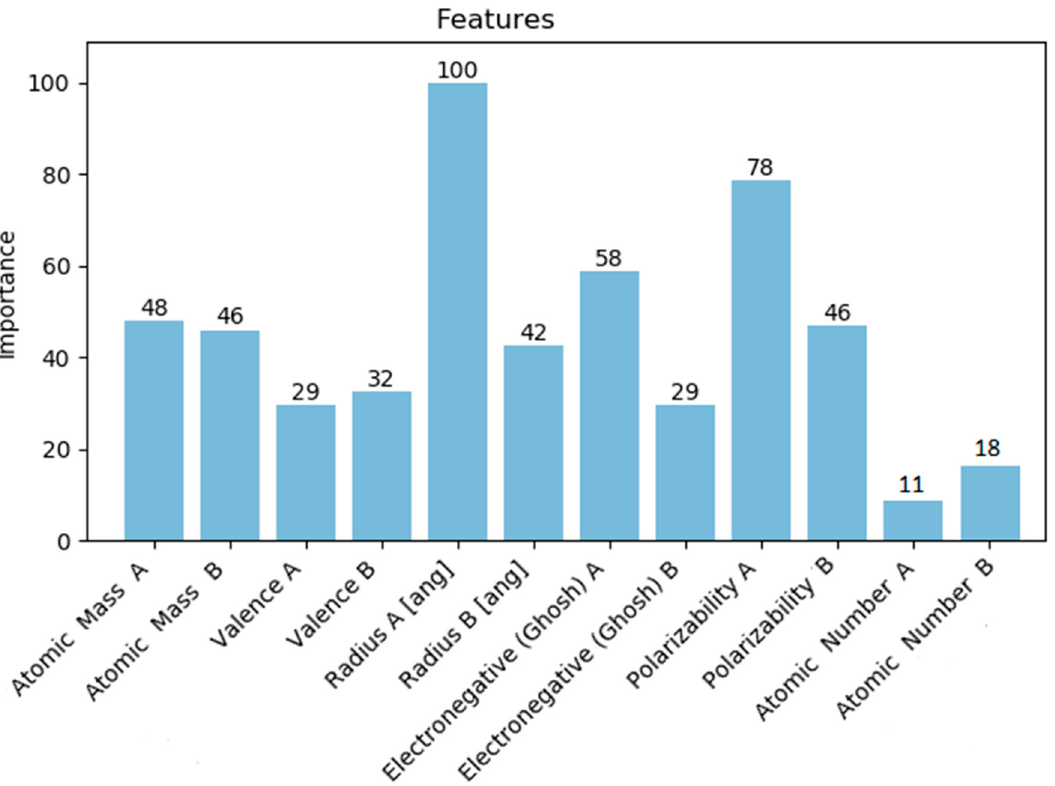
Figure 3. Importance of different features.